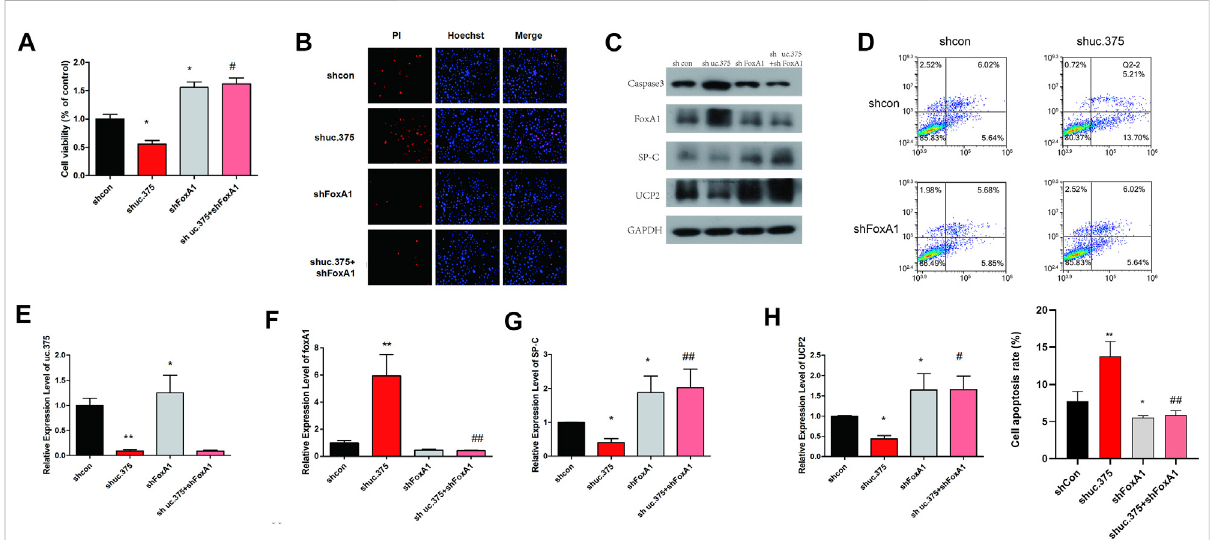
FIGURE 4 Effectsofuc.375silencingandFoxA1silencingonthefunctionofMLE12cells. (A) TheproliferationactivityofMLE12cellswasdetectedbyCCK- 8assay. (B) ThecellapoptosiswasdeterminedbyHoechst/PIstaininginMLE12cells. (C) Theproteinlevelsofcaspase3,FoxA1,SP-CandUCP2were investigated by western blot in MLE 12 cells. (D) The cell apoptosis was determined using low cytometry assay in MLE 12 cells. (E-H) The relative mRNAexpressionlevelsofuc.375,FoxA1,SP-CandUCP2weredetectedbyqRT-PCRinMLE12cells.* p < 0.05,** p < 0.01vssh-Con.# p < 0.05, ## p < 0.01 vs.. sh